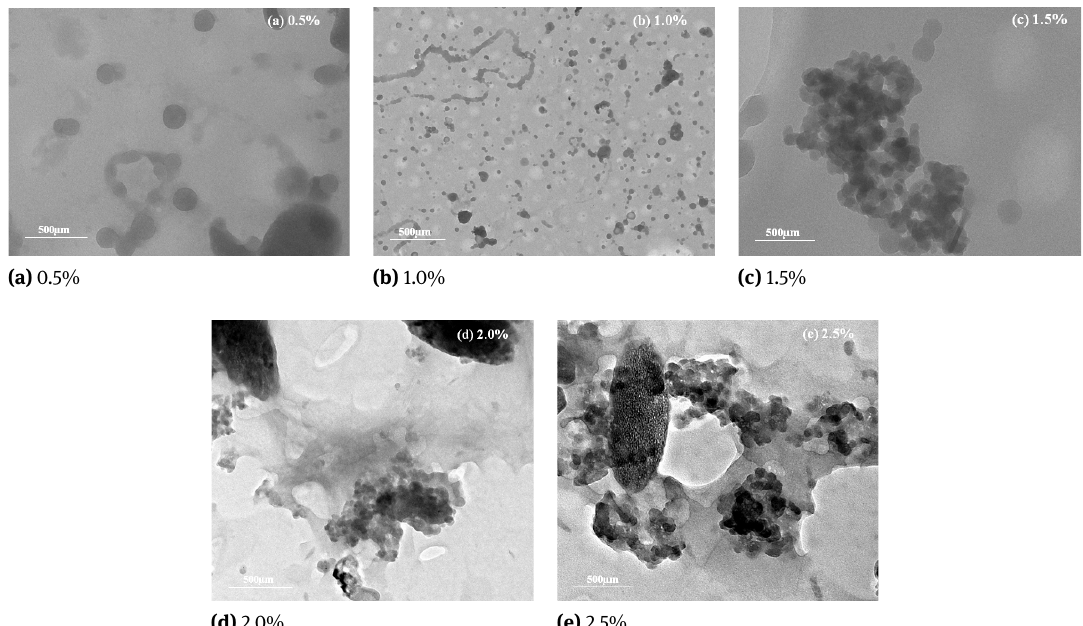
Figure 2: Transmission electron microscopy (TEM) images showing the clustered particles of the hollow glass microspheres dispersed in the syntactic foam composite at each volume fraction.